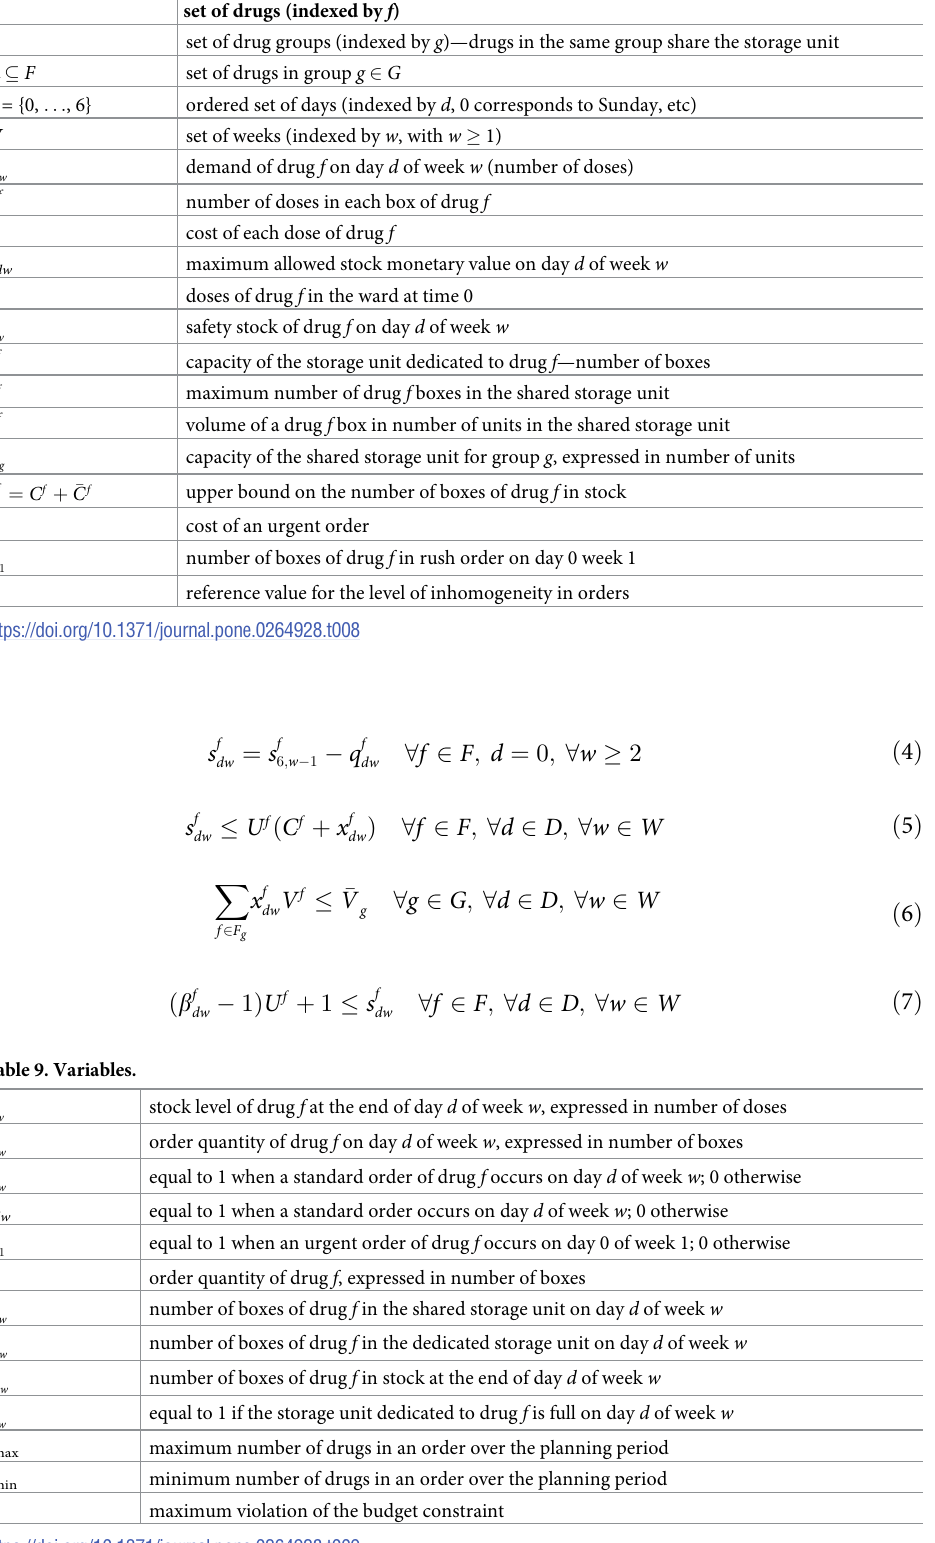
Table 8. Sets and parameters.